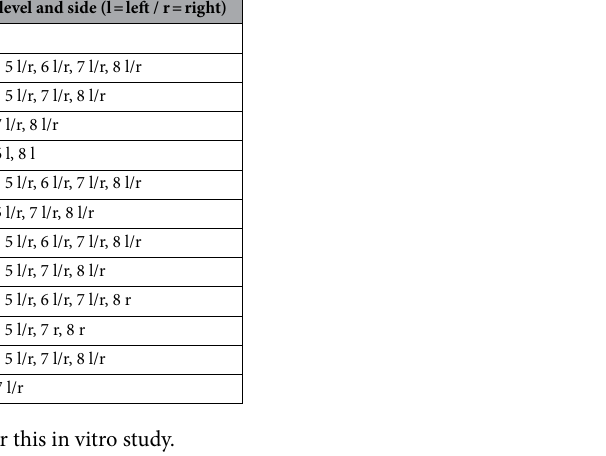
Table 1. Data on specimens used for this in vitro